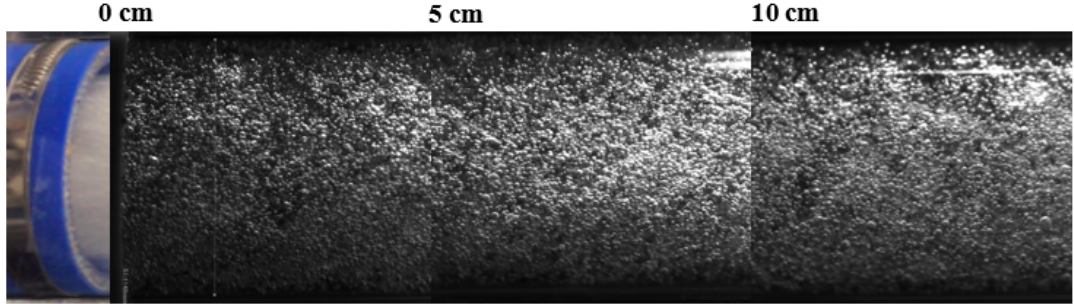
Figure 12. HSC images of the aerated water stream in the CLR along the flow at 1.1 m/s.